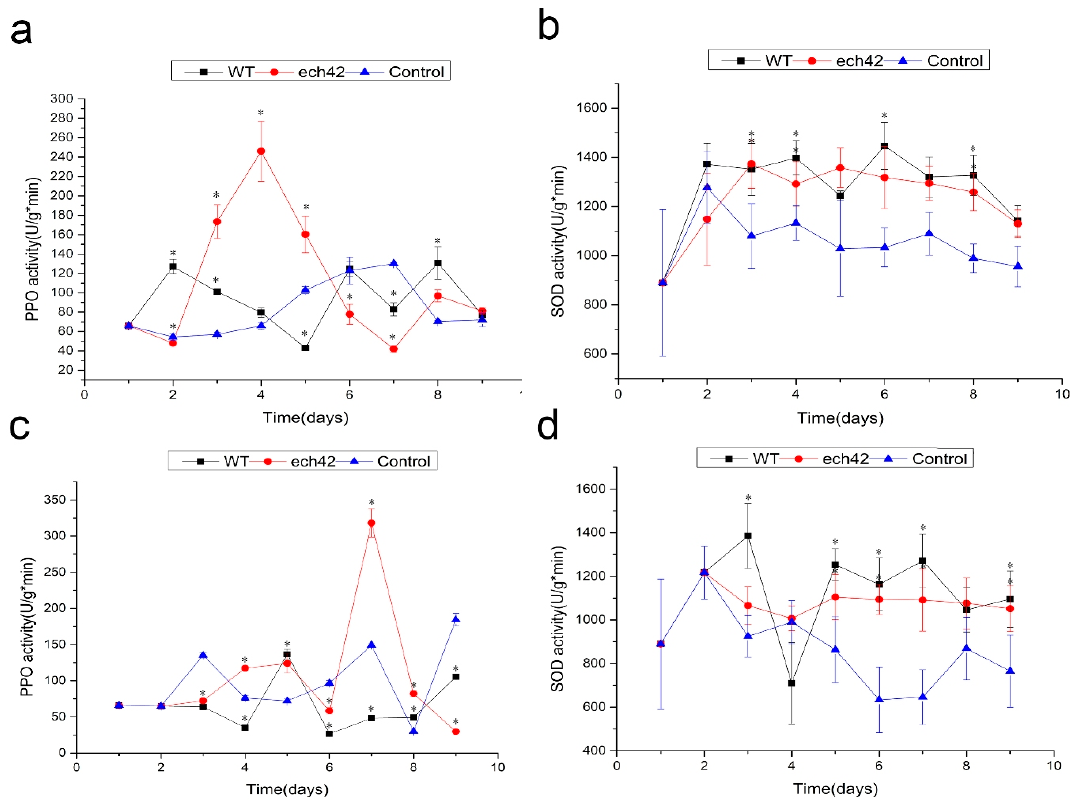
Figure 3. Changes of PPO ( a , c ) and SOD ( b , d ) activities during prevention ( a , b ) and treatment ( c , d ) experiments against Botrytiscinerea on tomato plants. WT: B. amyloliquefaciens ; ech42: B. amyloliquefaciens- ech42; control: not treated with either WT or ech42. “*”: indicates statistically significant results.